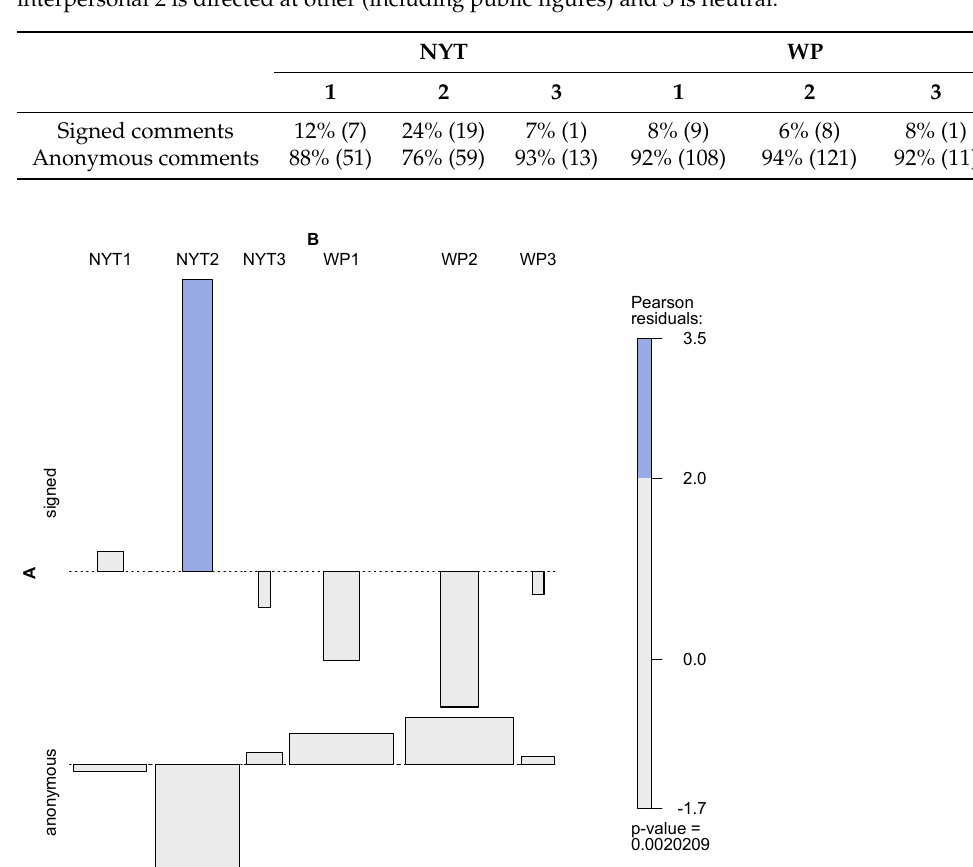
Table 4. Proportions of toxic comments divided up on what the comments are directed at: 1 is interpersonal 2 is directed at other (including public figures) and 3 is neutral.